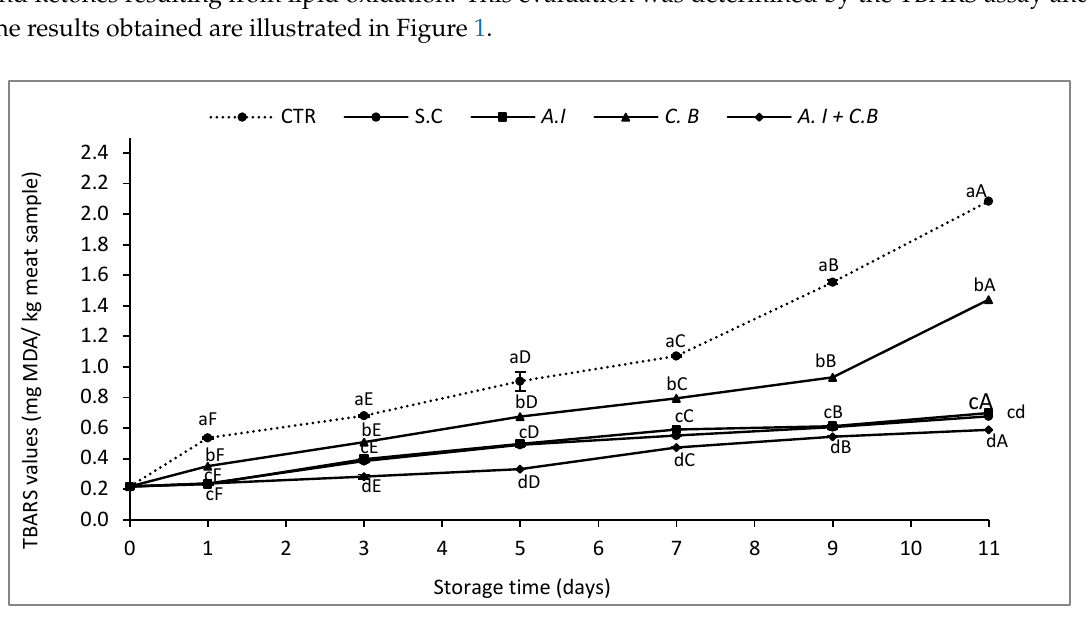
Figure 1. Thiobarbituric acid reactive substance (TBARS) values of raw beef patties during storage at 4 ± 1 ◦ C. CTR (Control sample without antioxidant), S.C (treatment with 0.7% (w / w) synthetic conservative), A.I (treatment with 0.7% (w / w) powdered A. indica leaves), C.B (treatment with 0.7% (w / w) powdered C. baccatum fruits) and A.I + C.B (treatment with 0.7% (w / w) powdered A. indica leaves and 0.7% (w / w) powdered C. baccatum fruits). Results represent the mean of three replicates ( n = 3) and are expressed as mean value ± SD; di ff erent letters in the same day indicate significant di ff erence between samples at p < 0.05, di ff erent capital letters indicate significant di ff erence between storage days at p < 0.05 for the same sample.